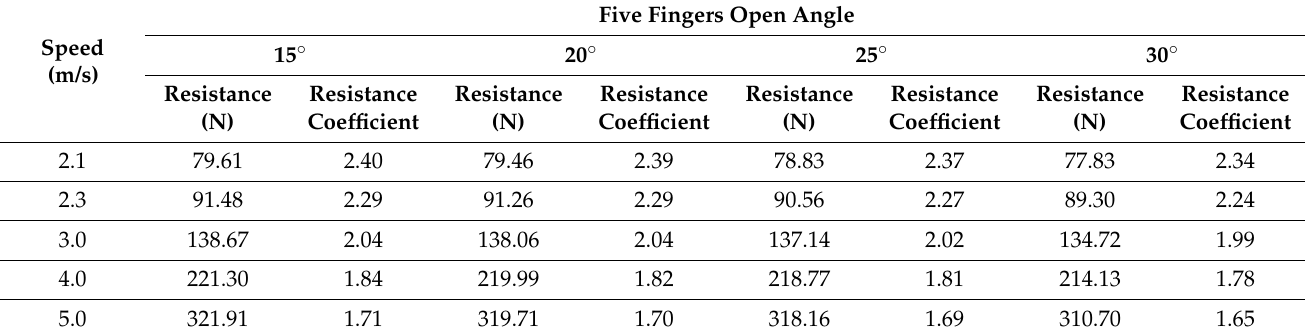
Table 5. Resistance and resistance coefficient scales corresponding to different five-finger tension angles and speeds.